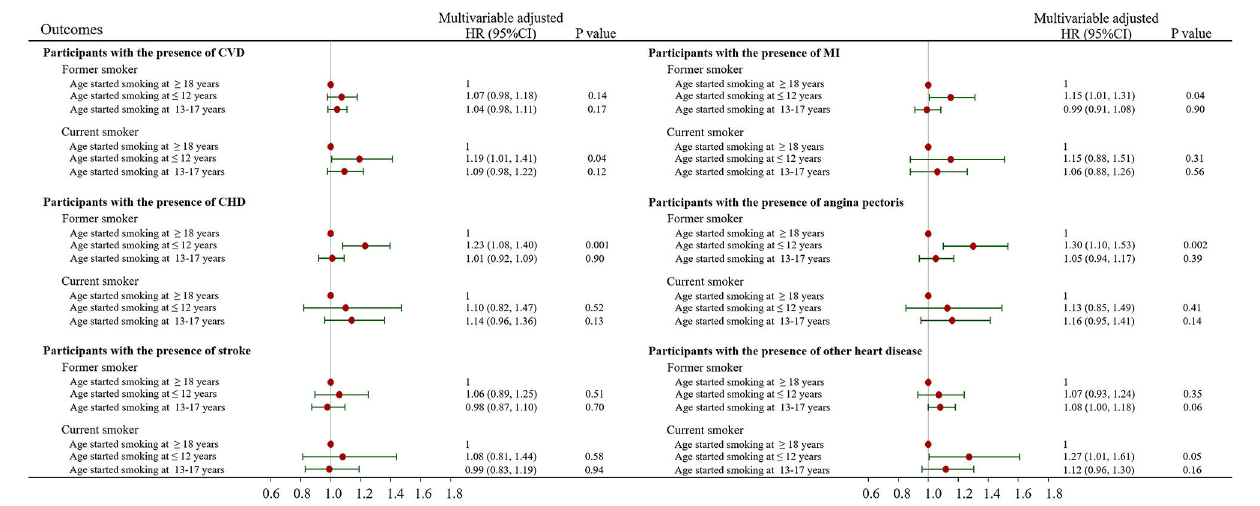
FIGURE 4 | Association of the age of smoking initiation with all-cause, CVD and cancer mortality stratified by the presence of cardiovascular disease. The multivariable-adjusted model was adjusted for age, sex, race, education, income, body mass index, physical activity, alcohol intake, baseline hypertension, diabetes and cancer variables. CI, confidence interval; HR, hazard ratio; CVD, cardiovascular disease; CHD, coronary heart disease; MI, myocardial